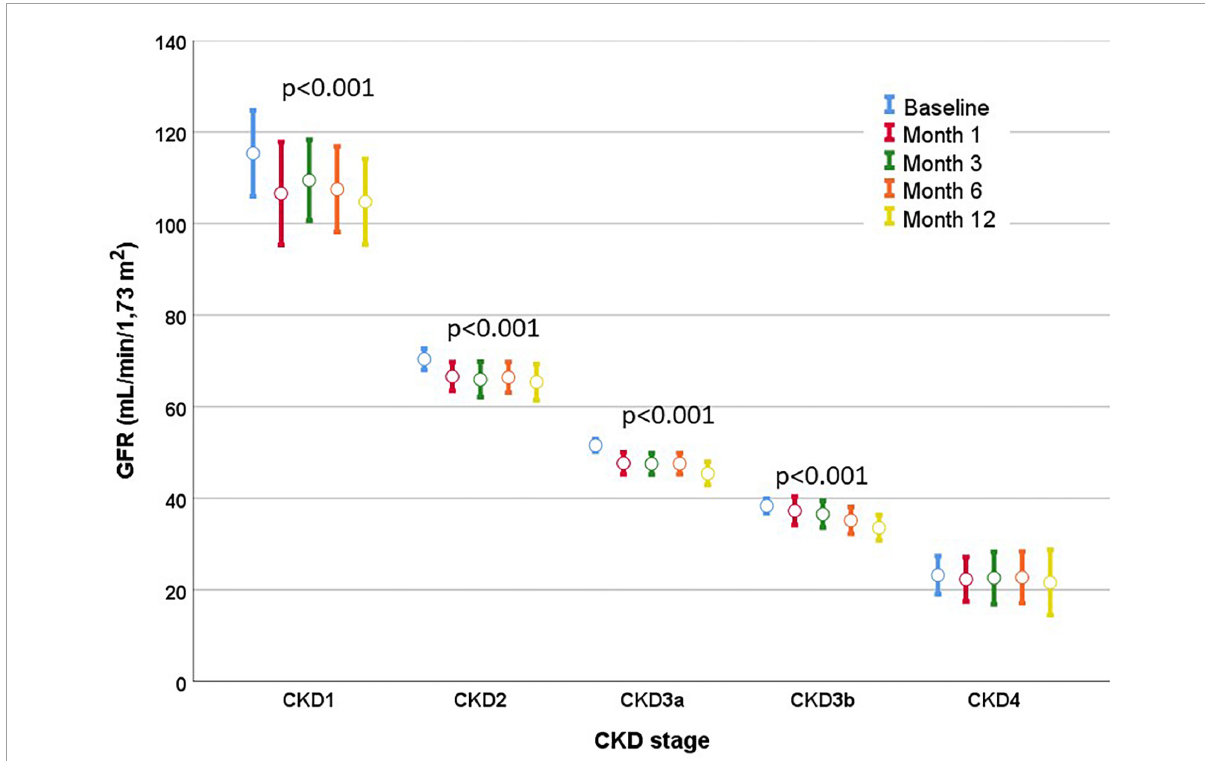
FIGURE3 Evolution of the eGFR according to the stage of CKD. A drop in eGFR was observed in the first month, with subsequent stable values during the first year of treatment in all stages. Mean eGFR and mean standard errors are shown.